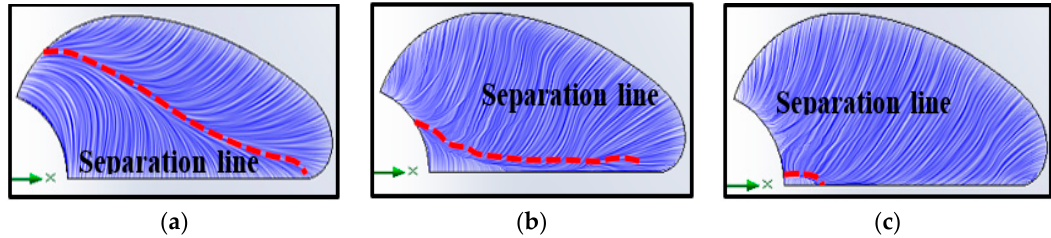
Figure 10. Streamline distribution on the blade pressure side at various TSR : ( a ) TSR = 1.0; ( b ) TSR = 2.0; ( c ) TSR = 4.0.